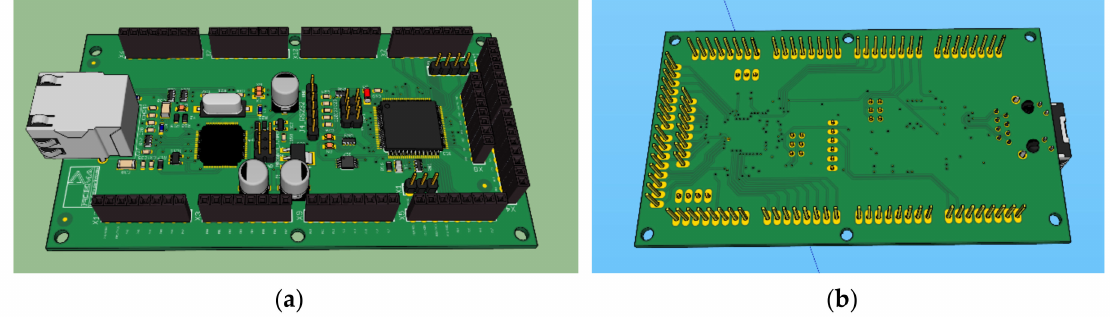
Figure 4. A 3D view of the GHC module: ( a ) front side; ( b ) back